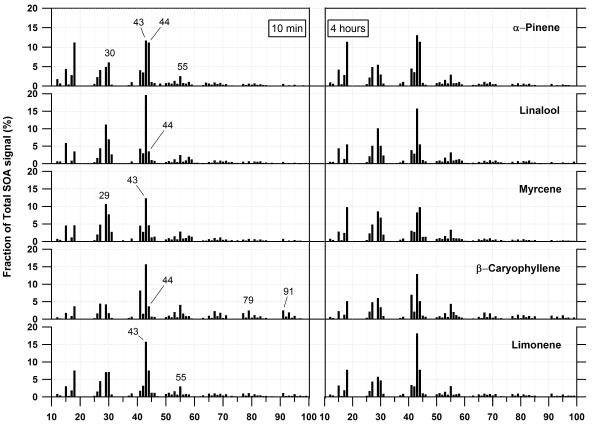
Fig. 2. Mass spectral patterns of SOA from the photooxidation of biogenic VOCs (data from the lower initial mixing ratio experi- ments reported in Table 1). The left-hand panels include spectra measured during the first 10min of SOA formation, while those measured after 4h of photooxidation are displayed in the right-hand panels. Each spectra has been normalised to the total SOA signal.